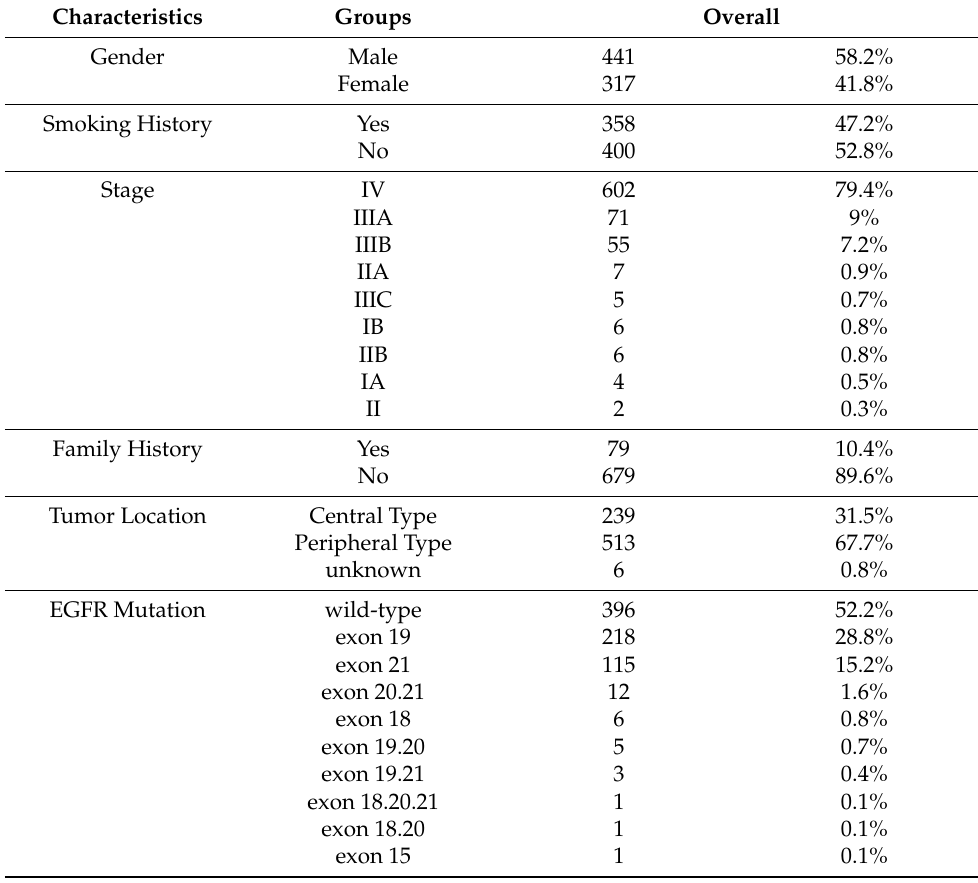
Table 1. Clinical characteristics of